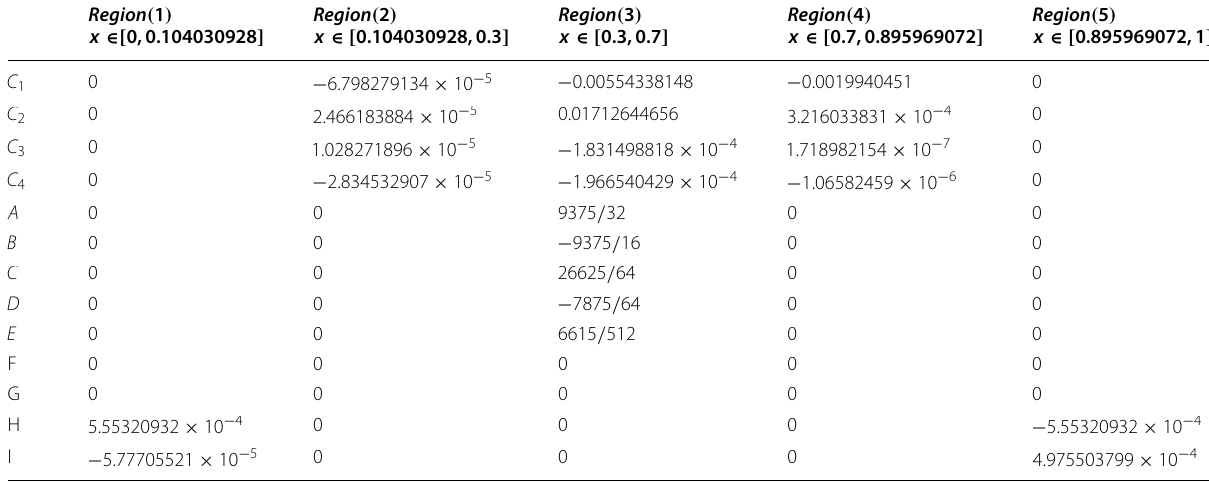
Table 10 Integration constants for exact solutions of cases (4) Region ( 1 ) x ∈ [ 0,0.104030928